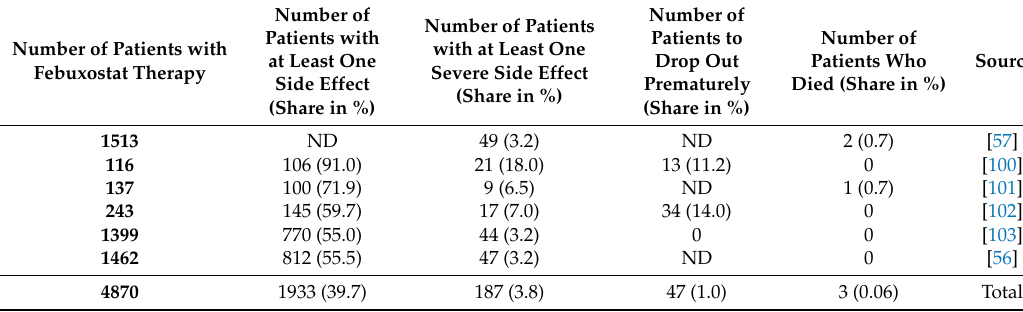
Table A2. Adverse events in the secondary analyses (number of patients examined per study (column 1); patients with at least one side effect (column 2); patients with at least one severe side effect (column 3); patients who dropped out of the study prematurely (column 4); patients who died (column 5); publications reviewed (column 6); differentiation between side effect and severe side effect according to the respective publication, no standard